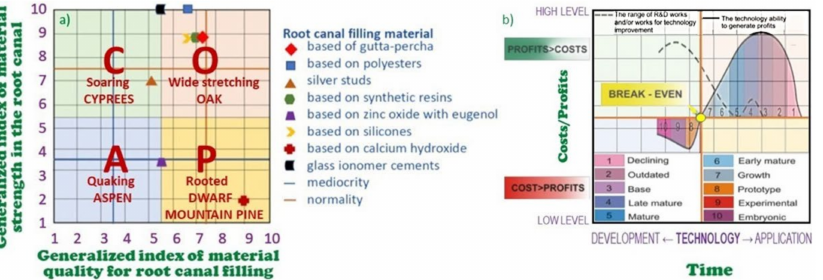
Figure 4. Contextual matrices: ( a ) the attractiveness of the materials used to fill the root canals in the form of the COAP dendrological matrix (soaring cypress-wide-stretching oak-quaking aspen-rooted dwarf mountain pine); ( b ) scheme of technology’s life